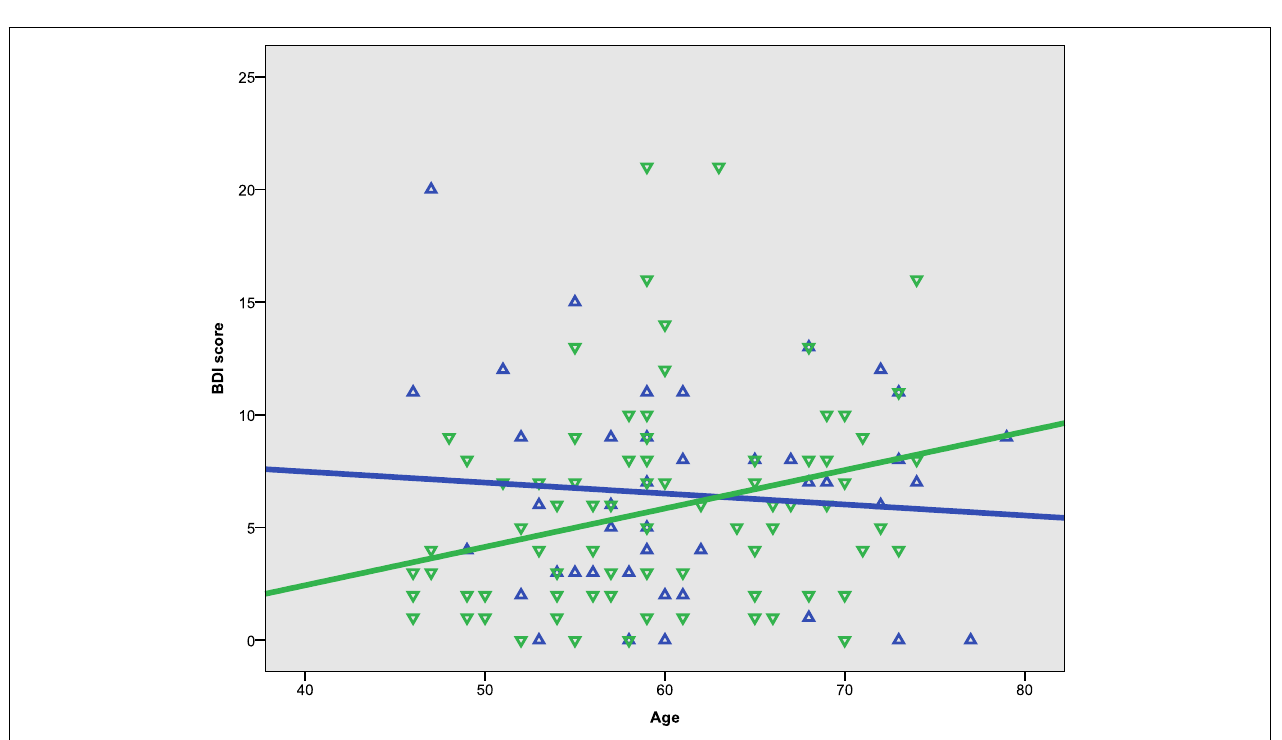
FIGURE 1 | Scatterplots of age with BDI score . Green represents female, blue represents